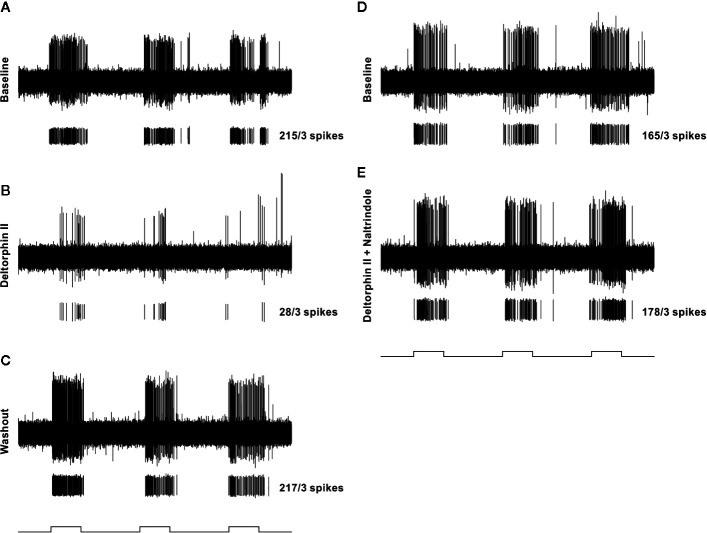
Representative example of testing protocol and responses of an individual nociceptor before and after localized administration of test drugs that were restricted to a cylinder centered over the receptive field. In each panel (A–E), the top trace is a raw recording from a C-fiber mechanical nociceptor (CV 0.61 m/s; mechanical threshold 4.1 mN). Each lower trace contains individual spikes sorted in software from the raw trace along with the total number of spikes counted during the three stimulation periods. The test mechanical stimulus was 38 mN, and stimulus timing (5 s, each separated by 10 secs) is indicated at the bottom of each column. The left column shows baseline response before drug (A), response 2 min after 300 nM deltorphin II (B), and response after 20 min of washout (C). After washout, a new baseline was established (D) before application of 300 nM deltorphin II plus 300 nM naltrindole (E).